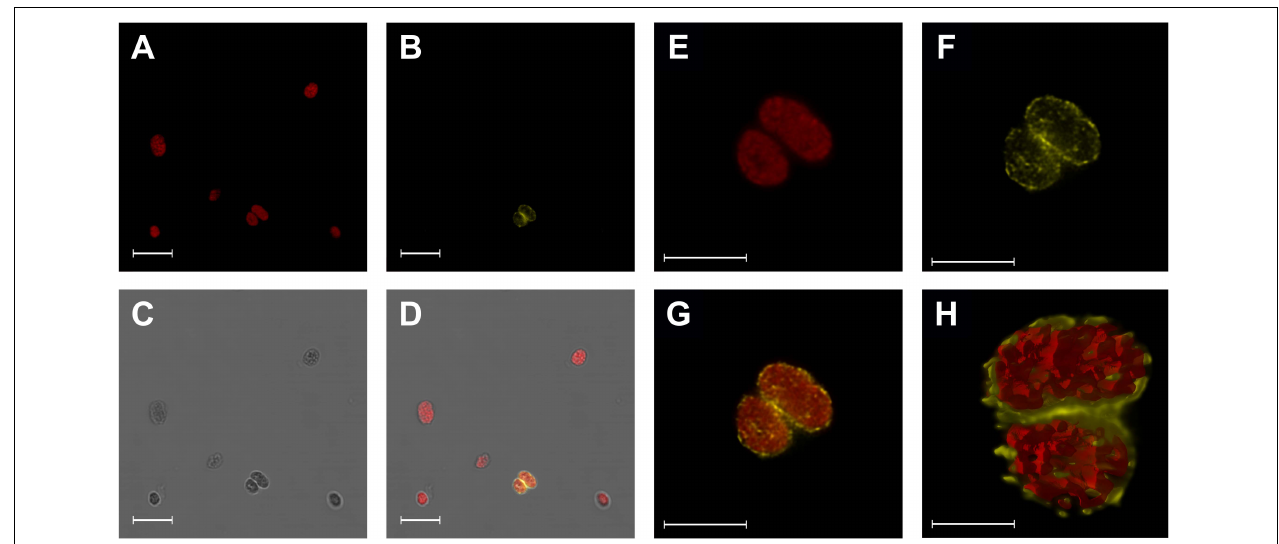
FIGURE 7 | Localisation of BnFRO7-GFP in the Phaseolus vulgaris chloroplasts detected by confocal microscopy of immunolabelled chloroplasts decorated with anti-GFP antibody. (A–D) Wild type and BnFRO7-GFP containing chloroplasts; chlorophyll autofluorescence. ( E–G) High resolution images of BnFRO7-GFP containing chloroplasts. (H) 3D reconstruction. Reconstruction of the same chloroplasts. Scale bars are 10 µ m (A–D) , 5 µ m (E–G) , and 2 µ m (H) . Colours: chlorophyll (red) and anti-rabbit-IgG Atto 550 conjugated antibody (yellow).